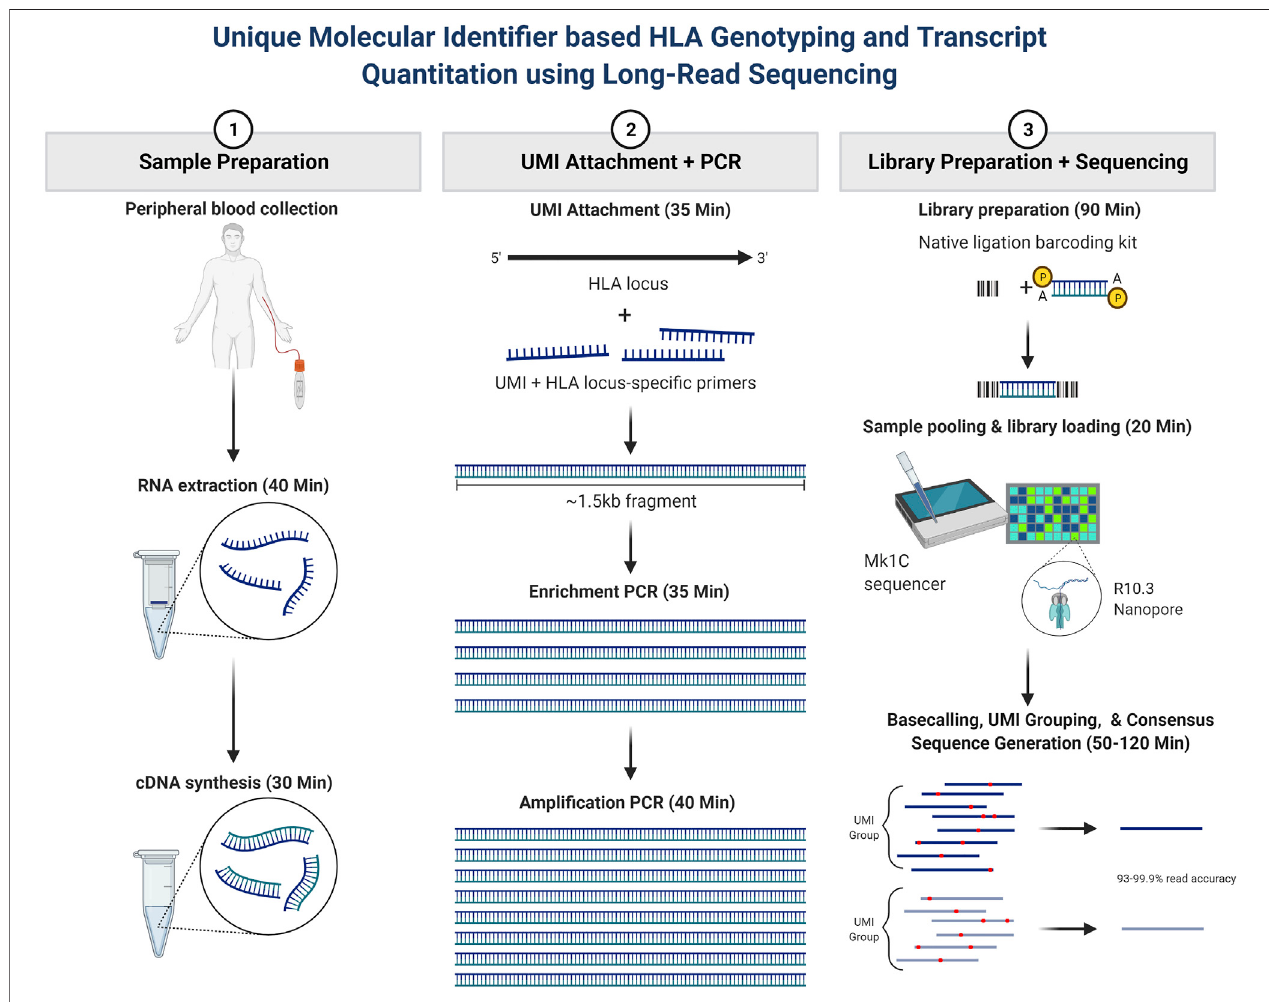
FIGURE 1 | Patient sample work fl ow for RNA isolation, library preparation, and resultant HLA typing as described based on consensus sequence generation. In short, total RNA was isolated from peripheral blood, and a portion of the total RNA was puri fi ed. RNA fragmentation and quantitation were determined, and an RNA integrity number (RIN) was calculated for each sample. cDNA synthesis was then performed, after which PCR ampli fi cation and puri fi cation were utilized to achieve the fi nal enriched HLA-locus speci fi c UMI tagged amplicon. The HLA gene-speci fi c amplicons for each patient were then used for library preparation and bar coding withtheOxford Nanopore Technologies(ONT) platform. Sequencing wasperformedusing theMinION R10.3FlowCelland loadedontheMinION Mk1Cusing thehigh- accuracybasecallingmodule.TheNGSenginebioinformaticspipelinewasthenutilizedtoprovideHLAtypingandAthlon2wasusedtogenerateHLAallele-speci fi cUMI